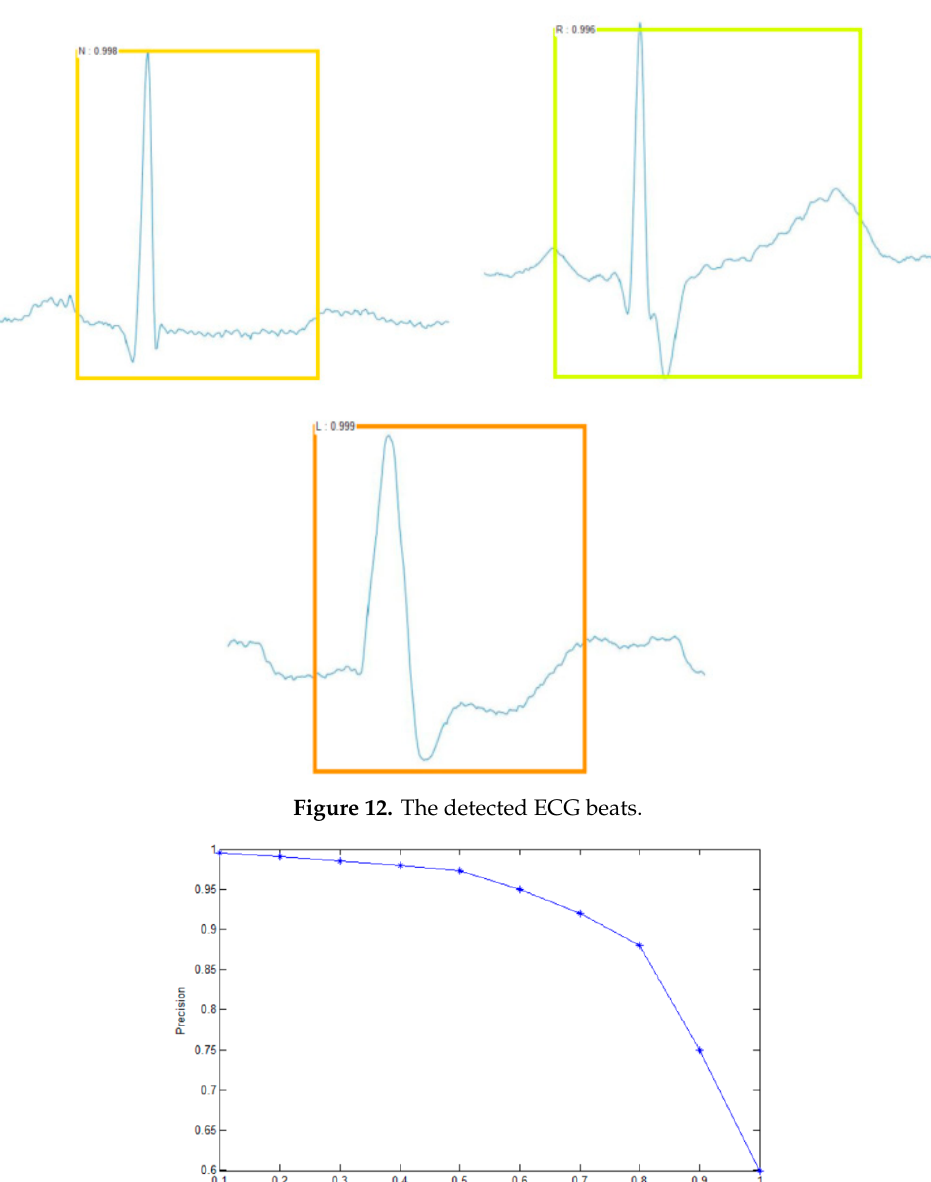
Figure 13. Score threshold test results.